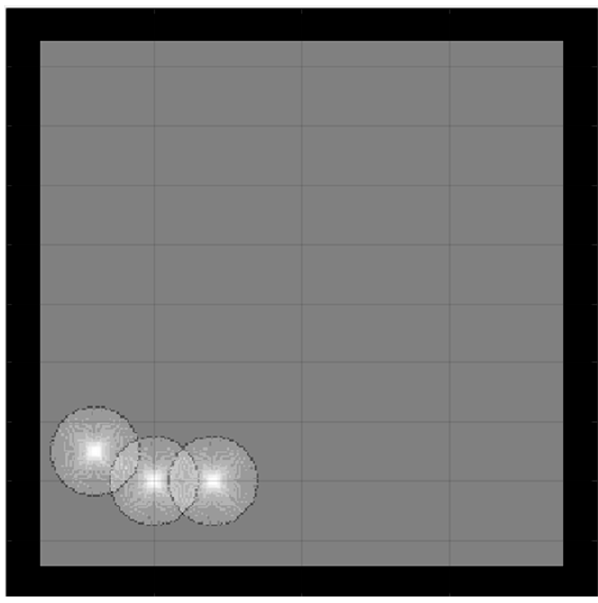
Figure 3. Initial position of coordinated exploration of three robots.